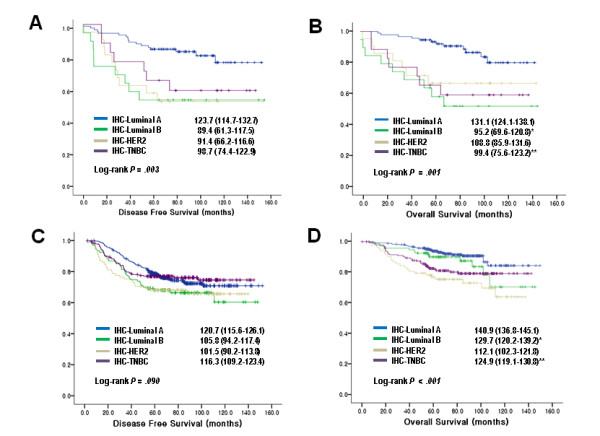
Association between chemotherapy and four-subtypes of breast cancers. Kaplan-Meier curves of disease-free survival (A and C) and overall survival (B and D). Cases without chemotherapy (A and B) and with chemotherapy (C and D) (Estimated mean survival with 95% CI). *P < 0.001, **P = 0.027